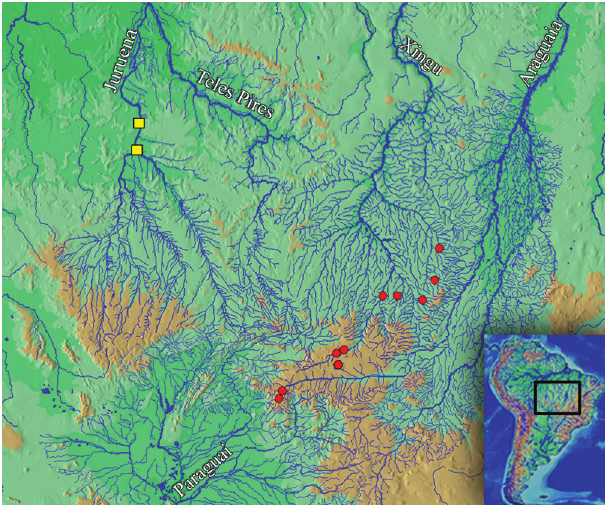
Fig. 5. Map of central South America, showing known localities of Hyphessobrycon peugeoti n. sp. (yellow squares) and H. loweae (red dots). The northern square includes the type- locality and two other localities of Hyphessobrycon peugeoti . Inset depicts the area of South America displayed in the